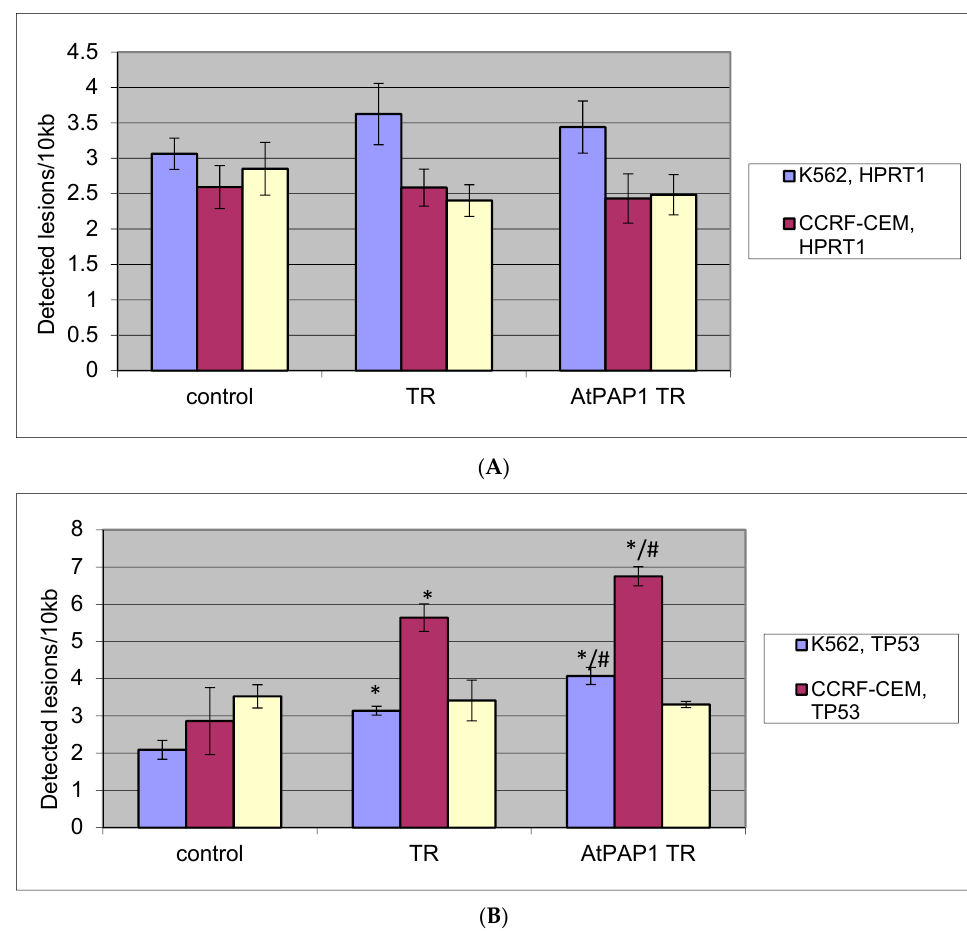
Figure 5. The effect of TR and AtPAP1 TR root extracts of L. sibiricus on nucelar DNA (nDNA) lesion frequency per 10 kb DNA in ( A ) HPRT1 and ( B ) TP53 genes, estimated by SLR-qRT-PCR amplification of total DNA from CCRF-CEM, K562 and A549. The data represent means ± SD. *: p < 0.05 Control vs. TR and AtPAP1 TR. #: p < 0.05 TR vs. AtPAP1 TR.